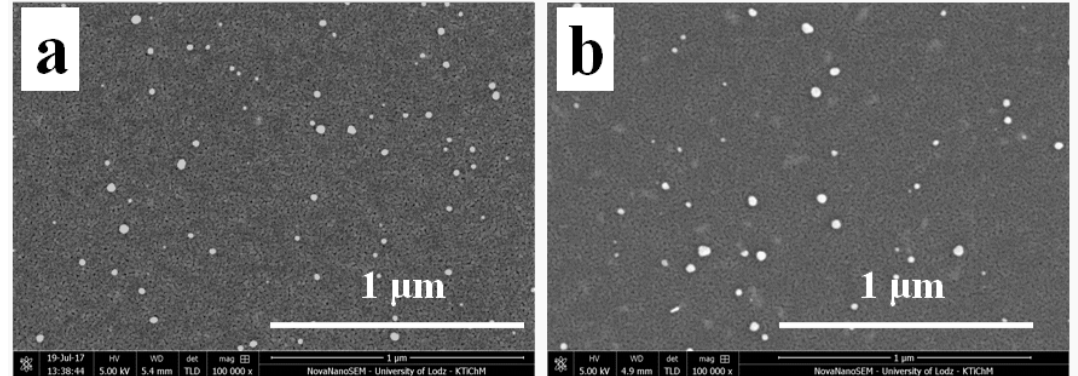
Figure 5. The morphology of GO area on TiO 2 -(GO-AgNS) ( a ) and on TiO 2 -GO-AgNS ( b ) coatings at a magnification of 100,000 ×.